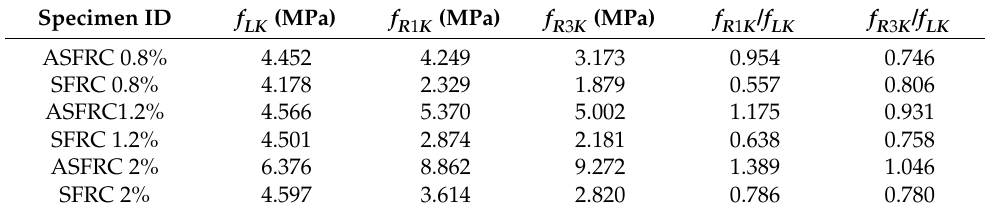
Table 3. Summary of the characteristic values of all